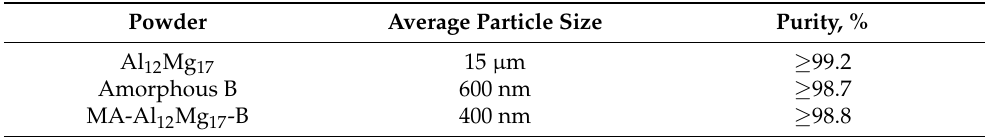
Table 1. Characteristics of the raw powders.